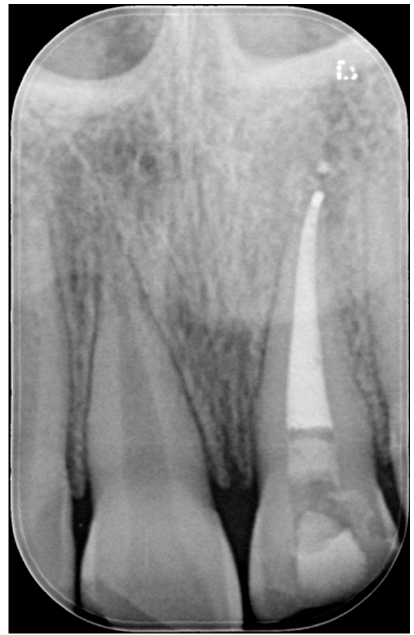
Figure 31. X-ray after endodontic treatment. Reprinted from Restauri diretti nei settori anteriori, G. Paolone, S. Scolavino, © 2021, with permission from Quintessence Publishing Italy.